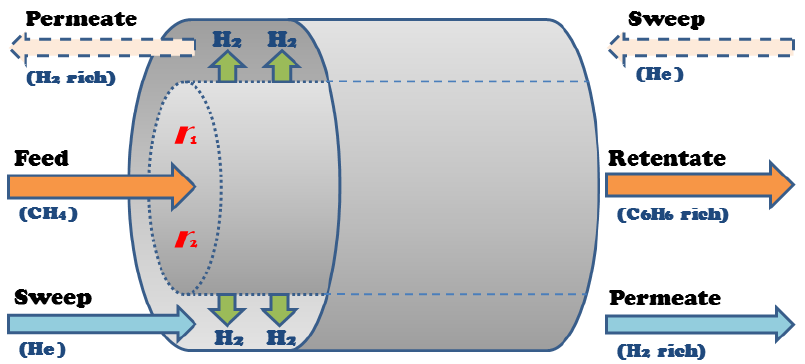
Figure 3. Membrane reactor co-current configuration [36].